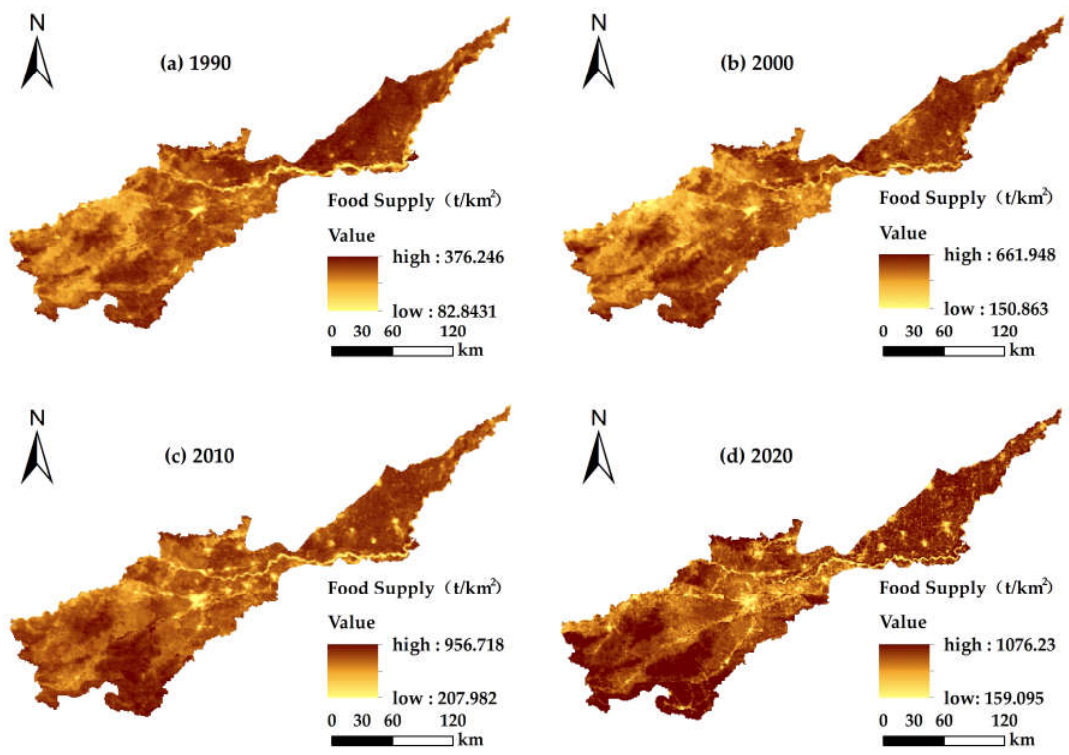
Figure 7. Spatial distribution of average food supply in the Yellow River Basin (Henan Section): ( a ) food supply map for 1990; ( b ) food supply map for 2000; ( c ) food supply map for 2010; ( d ) food supply map for 2020.